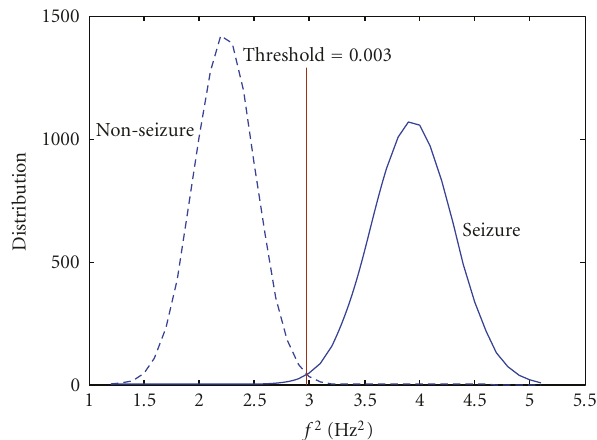
Figure 8: The Gaussian distribution to determine threshold for variance in HF.